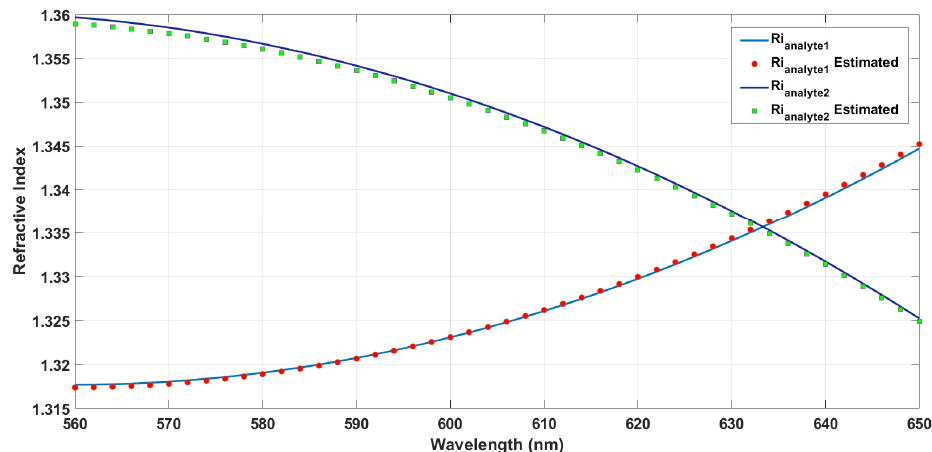
Figure 4. Comparison between two examples of the parabolic curves for normal and anomalous dispersions (continuous lines) and the data estimated using the coefficients calculated by the multivariate linear regression (dotted lines).